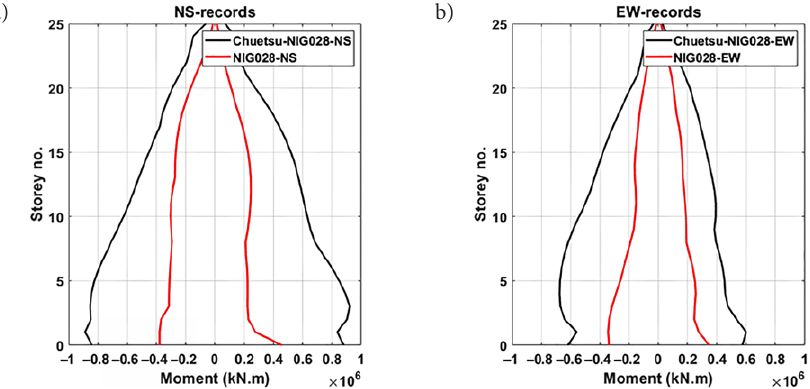
Figure 13. Peak story moment curves vs. story number under the NS and EW components of the Niigata records with and without sequences: a – transverse direction; b – longitudinal direction